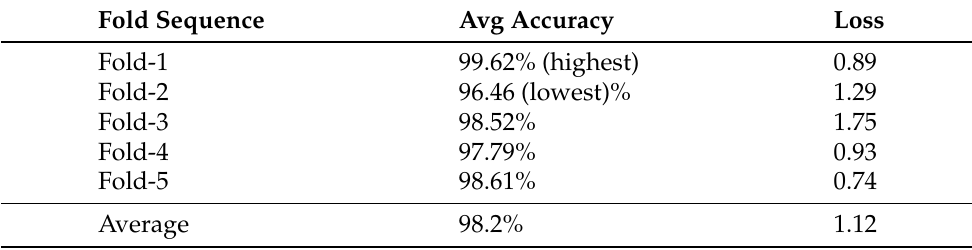
Table 7. Performance of SolNet for 5-fold Cross